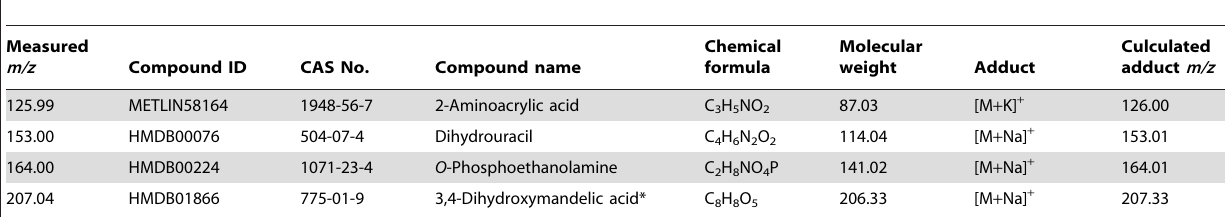
Table 1. Assignment of molecules at m/z 125.99, 153.00, 164.00, and 207.04 (* indicates the molecule identified by MS/MS